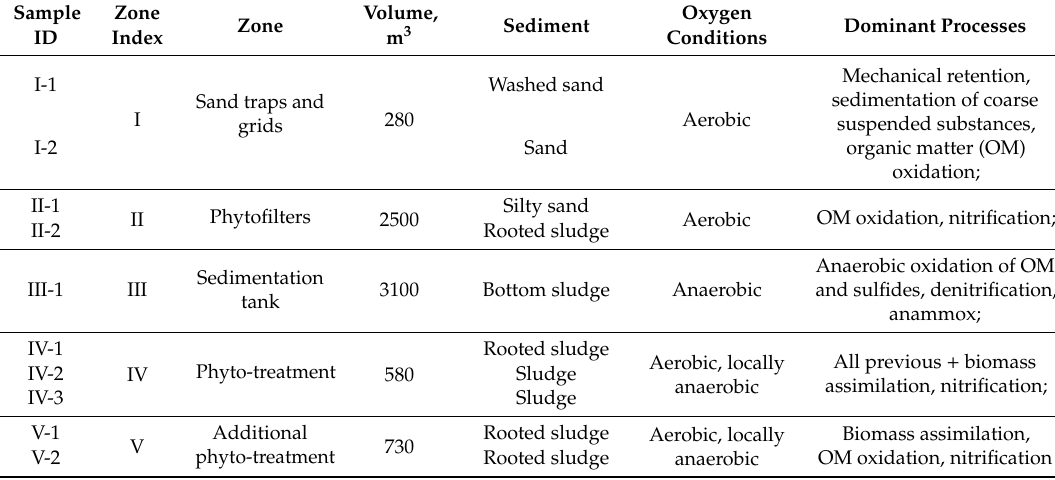
Figure 1. Scheme of the constructed wetland studied. Zone I represents sand traps and grids; zone II—phytofilters; zone III—sedimentation tank; zone IV—phyto-treament; zone V—additional phyto-treatment. One or several sub-zones were selected in each functional zone. Table 2. Functional zones of the constructed wetland.